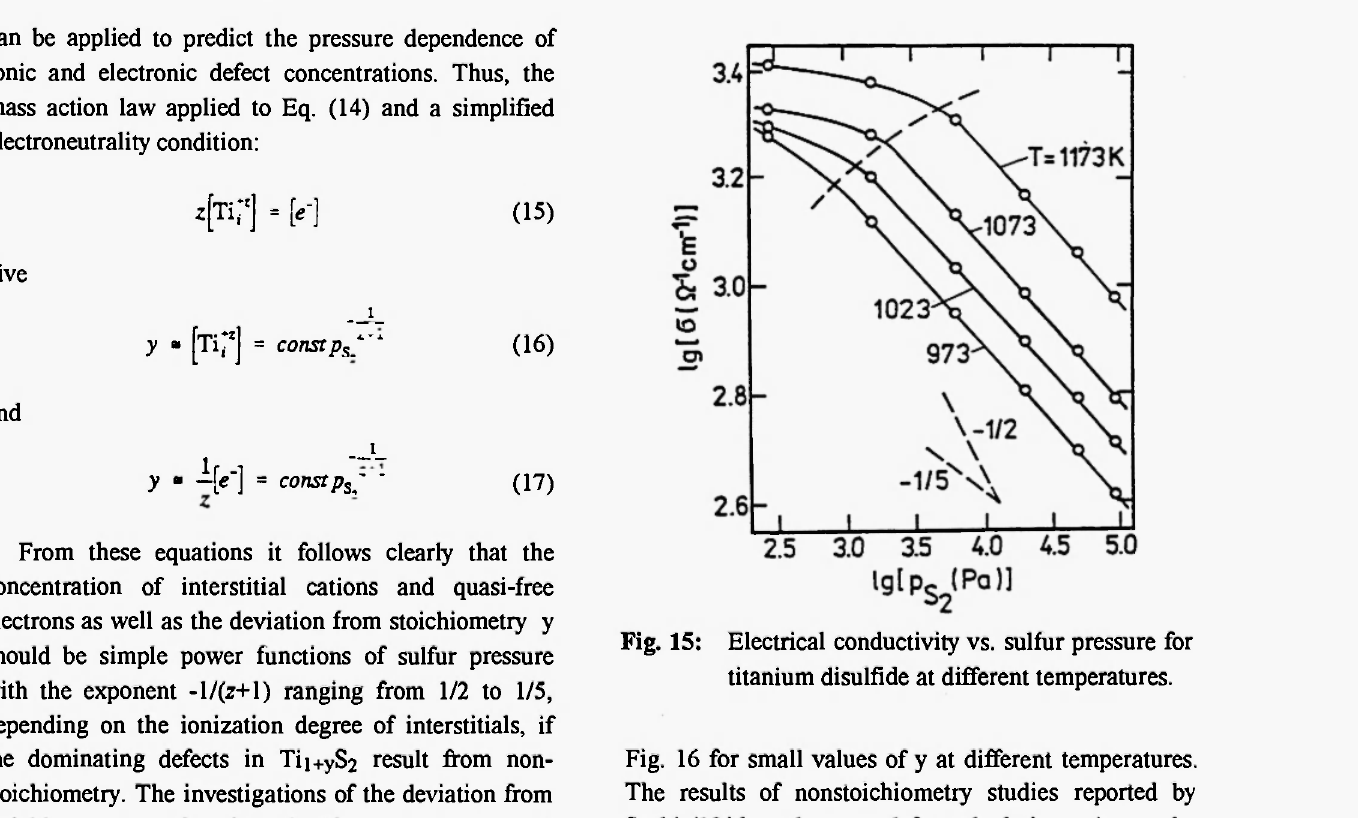
Fig. 15: Electrical conductivity vs. sulfur pressure for titanium disulfide at different temperatures. Fig. 16 for small values of y at different temperatures.